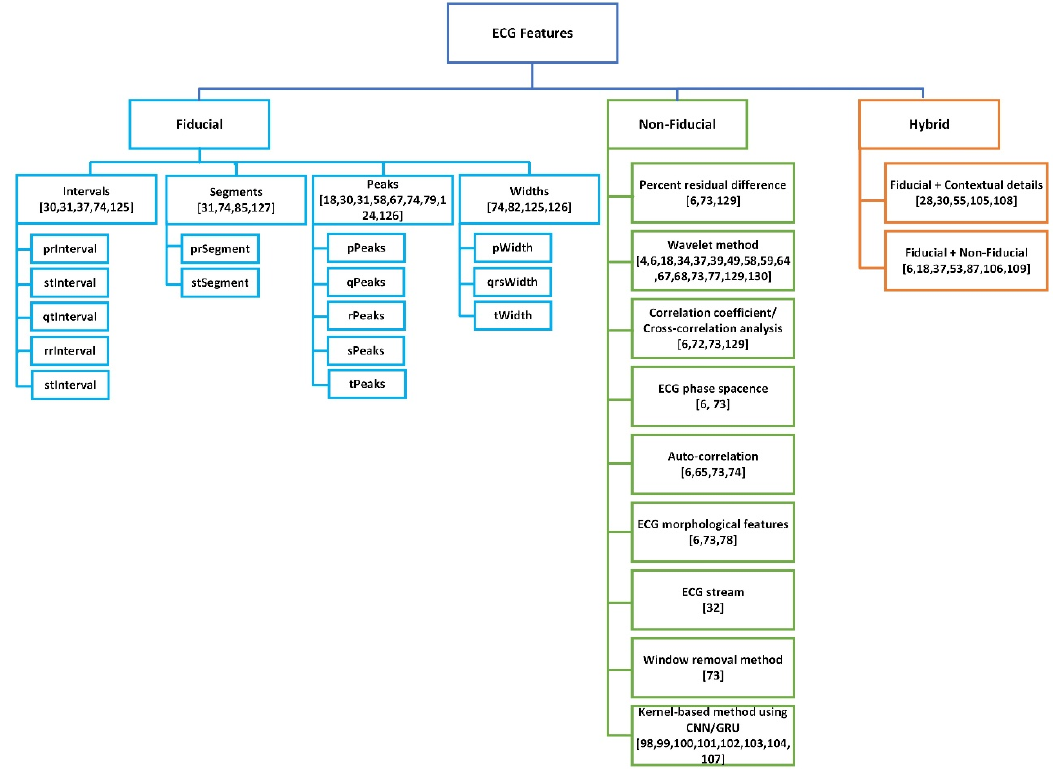
Figure 9. Taxonomy of features for ECG interpretation and diagnosis